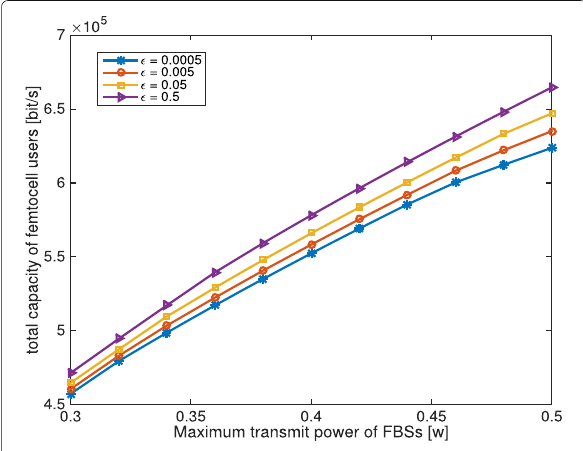
Fig. 6 Total data rate of FBSs vs. P max for different (cid:4)